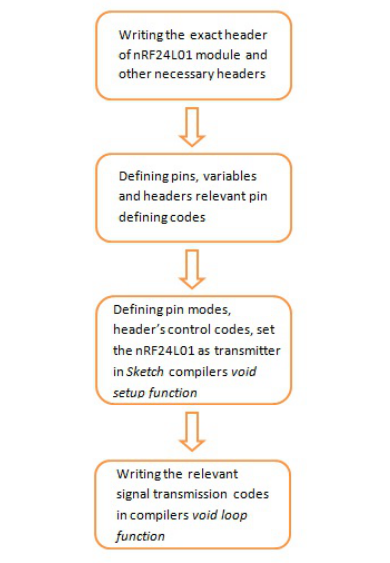
Fig. 16. Programming flow chart of